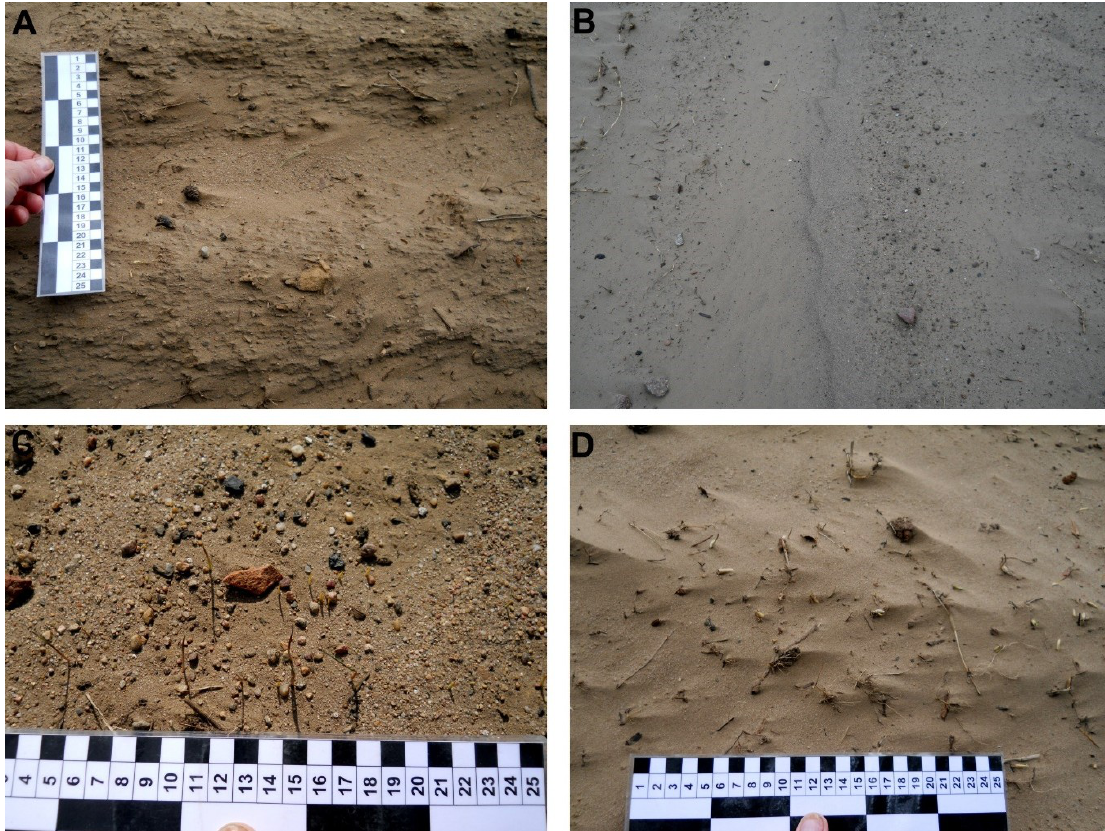
Figure 5. Aeolian erosive and accumulative forms in the research fields. ( A , B )—traces of aeolian corrasion; ( C , D )—deflation surface with aeolian paving; (photos taken on 9 April 2011). Mineral material extracted from fields accumulated mainly in the form of aeolian